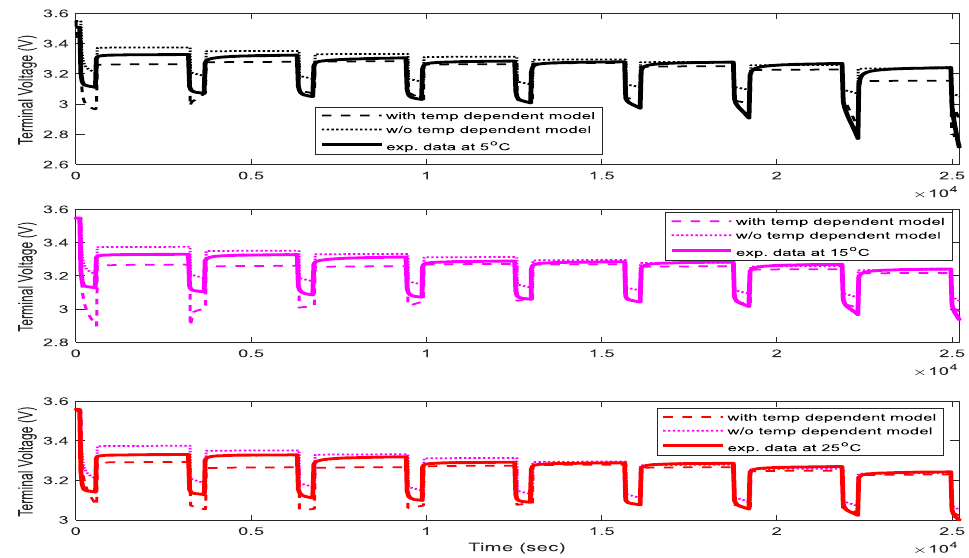
Figure 24. Terminal voltage at different ambient temperature (5 °C, 15 °C and 25 °C).